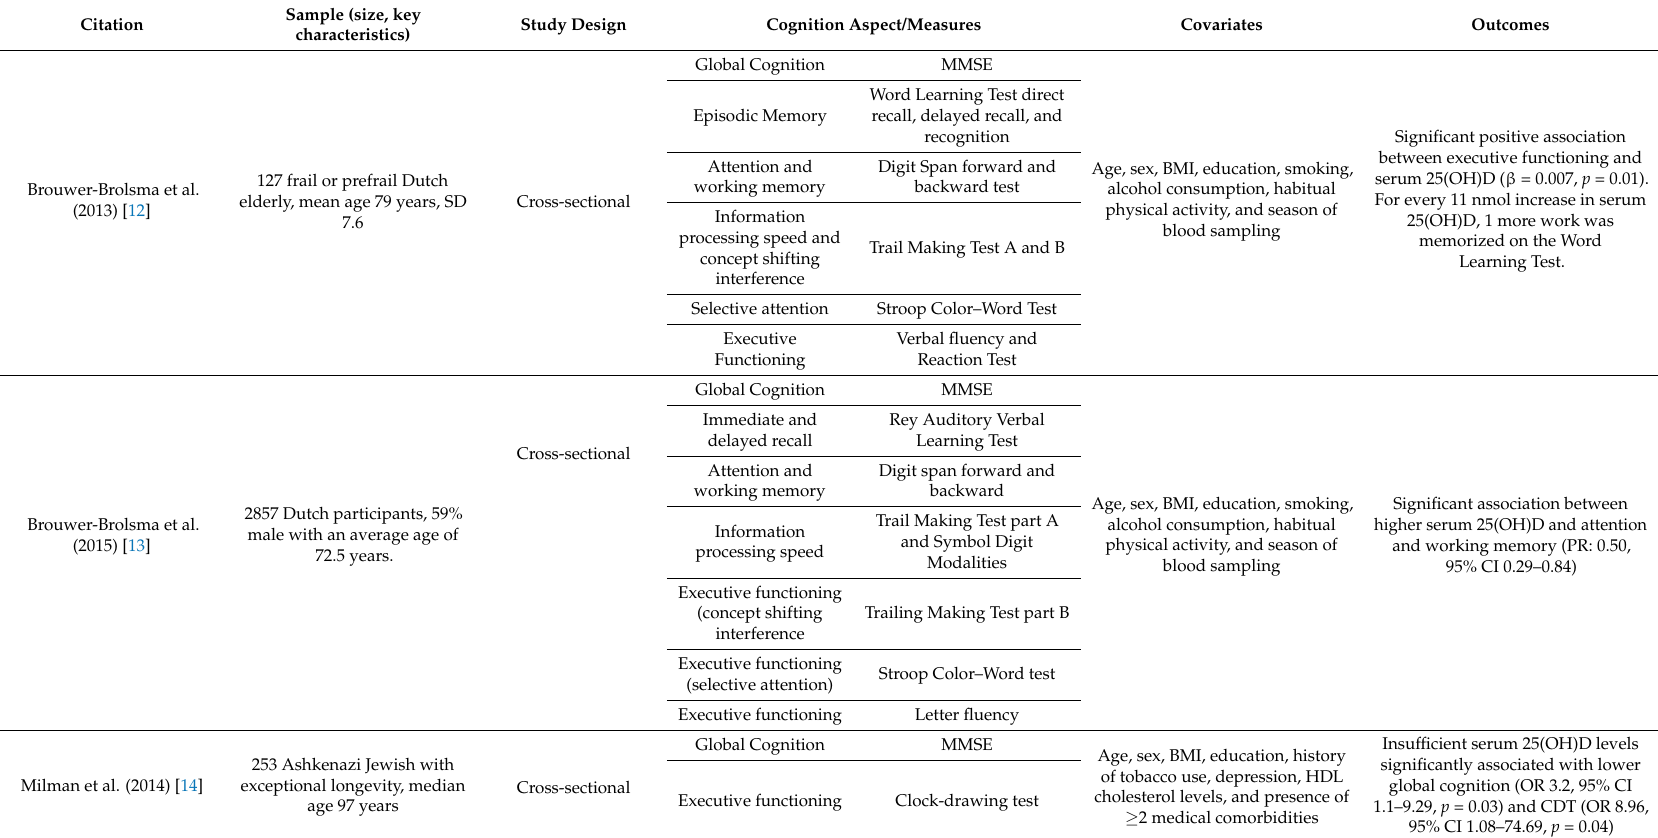
Table 1. Observational studies examining serum 25(OH)D and cognitive